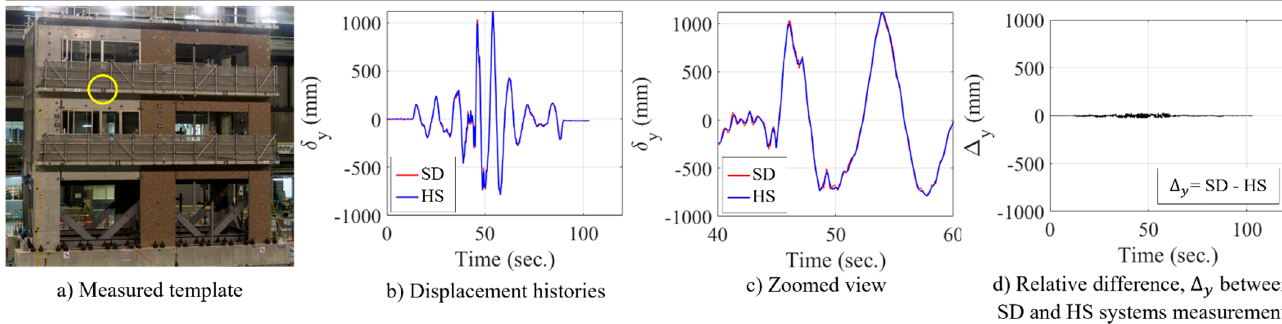
Figure 9. Comparison between high-speed and commercial DSLR system measurements of high-amplitude seismic excitation as measured from the marked template.